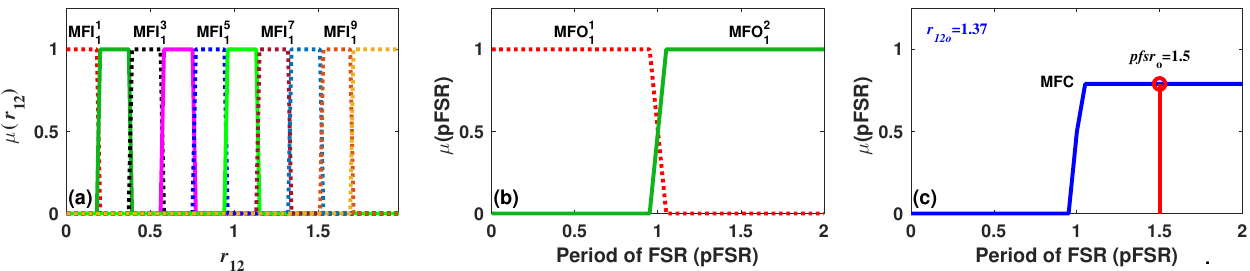
Figure 5. ( a ) Membership functions that will fuzzificate the input variable r 12 of filter 1; ( b ) Mem- bership functions related to output variable (period of FSR) of FIS1; ( c ) Example of a membership function of the consequence for a particular value of r 12 o at its